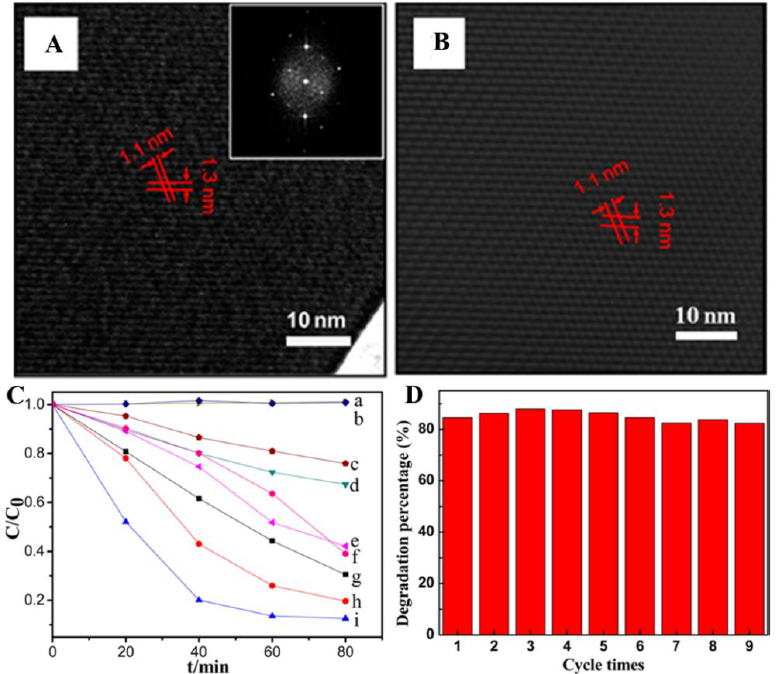
Figure 3. ( A ) The high resolution transmission electron microscope (HR-TEM) image of ZnTPyP tetragonal rods. The inset shows the fast Fourier transformation (FFT) of the transmission electron microscope (TEM) image. ( B ) Corresponding reverse fast Fourier transformation (RFFT) image built upon the FFT image. ( C ) Photocatalytic activities of ZnTPyP nanocrystals: no ZnTPyP nanocrystals (a), commercially available P25 TiO 2 nanoparticles (b), tetragonal nanorods with a 200-nm length (c), same concentration of ZnTPyP in DMF (d), same concentration of ZnTPyP in 0.01 M HCl (e), nanoparticles with an 80-nm diameter (f), hexagonal nanowires with a 2- µ m length (g), hexagonal rods with a 400-nm length (h) and hexagonal porous nanodiscs (i) for methyl orange (MO) photodegradation under visible-light irradiation. ( D ) Cycling tests of photocatalytic activity of ZnTPyP nanodiscs under visible-light irradiation. Reprinted with permission from [58]. Copyright 2014, American Chemical Society.